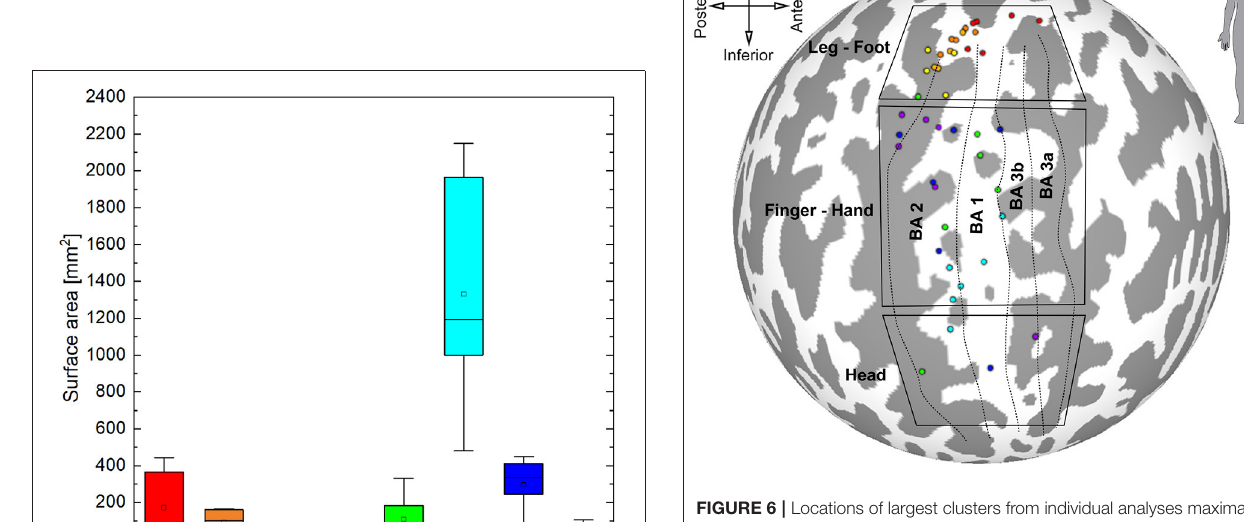
FIGURE 6 | Locations of largest clusters from individual analyses maximally correlated to each peripheral stimuli. Cluster locations are shown on Colin 27 cortical surface map. Colored dots are centered on cluster center of gravity. Labeled boxes delineate regions of interest for certain body areas based on results from Penfield and Boldrey (1937) and Roux et al. (2018). Approximate parcellations of Brodmann’s areas are shown as dotted lines. Top-left: anatomical orientation of spherical map. Top-right: color scheme corresponding to stimulator